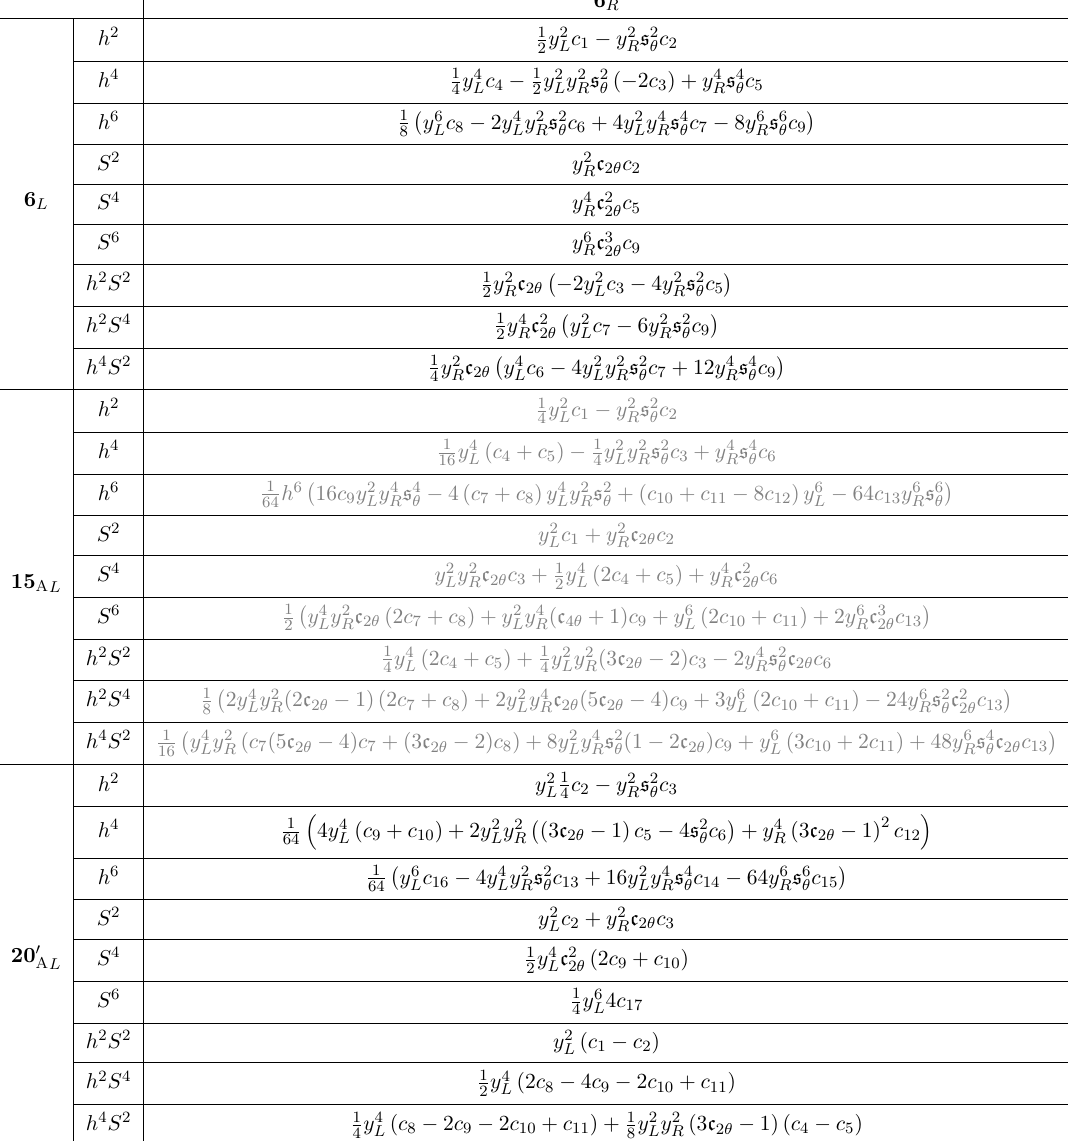
Table 2 . V ( h, S ) terms obtained via our spurion analysis for t R in a SO(6) sextuplet. Only leading terms are shown and each entry should be multiplied by N c m 4 with a factor 1 /f and every y L,R with a 1 /g ∗ . The 15 L model does not generate a CPV-inducing term and is thus displayed in gray. Parameters that contribute in the same way in the given approximation were collected into single c i and we abbreviate c 2 θ = cos 2 θ 6R and s 2 while the other angle is set to zero, respectively. As discussed in the text, going to finite values of the displayed angle changes the hierarchy of terms for the 20 0 L